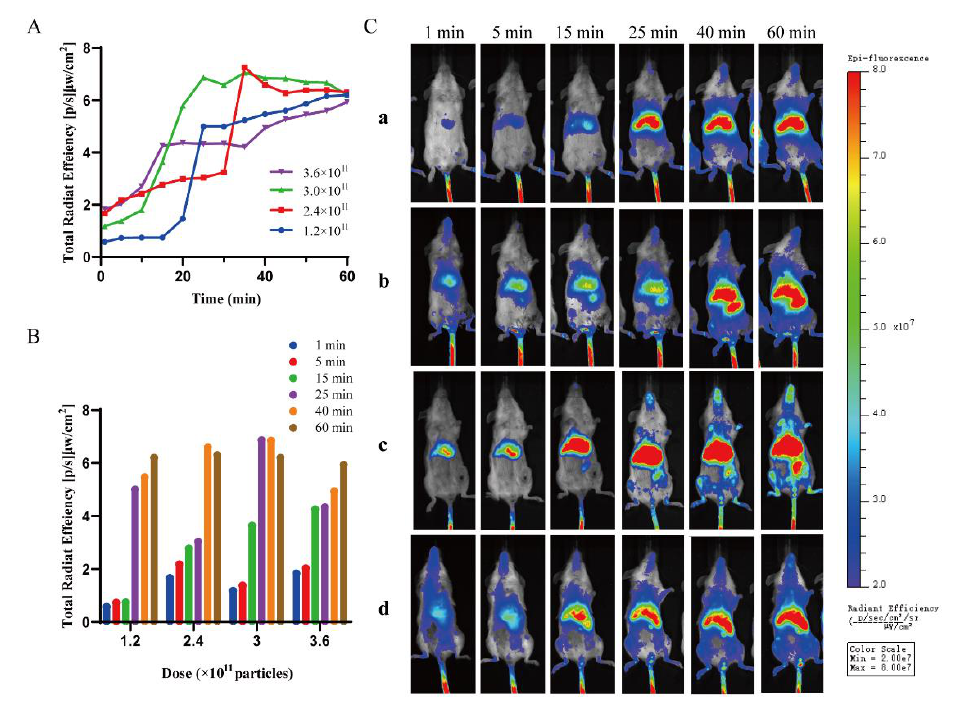
Figure 3. Characterization of threshold in vivo. ( A ) Temporal curve of fluorescence intensity quan- tification in liver regions. ( B ) Quantitative comparison of fluorescence intensity of liver region at six representative time points at different doses. ( C ) Representative image of live imaging in ( B ). The four concentrations of DiR-BSA nanoparticles are a = 1.2 × 10 11 , b = 2.4 × 10 11 , c = 3 × 10 11 , and d = 3.6 × 10 11 .